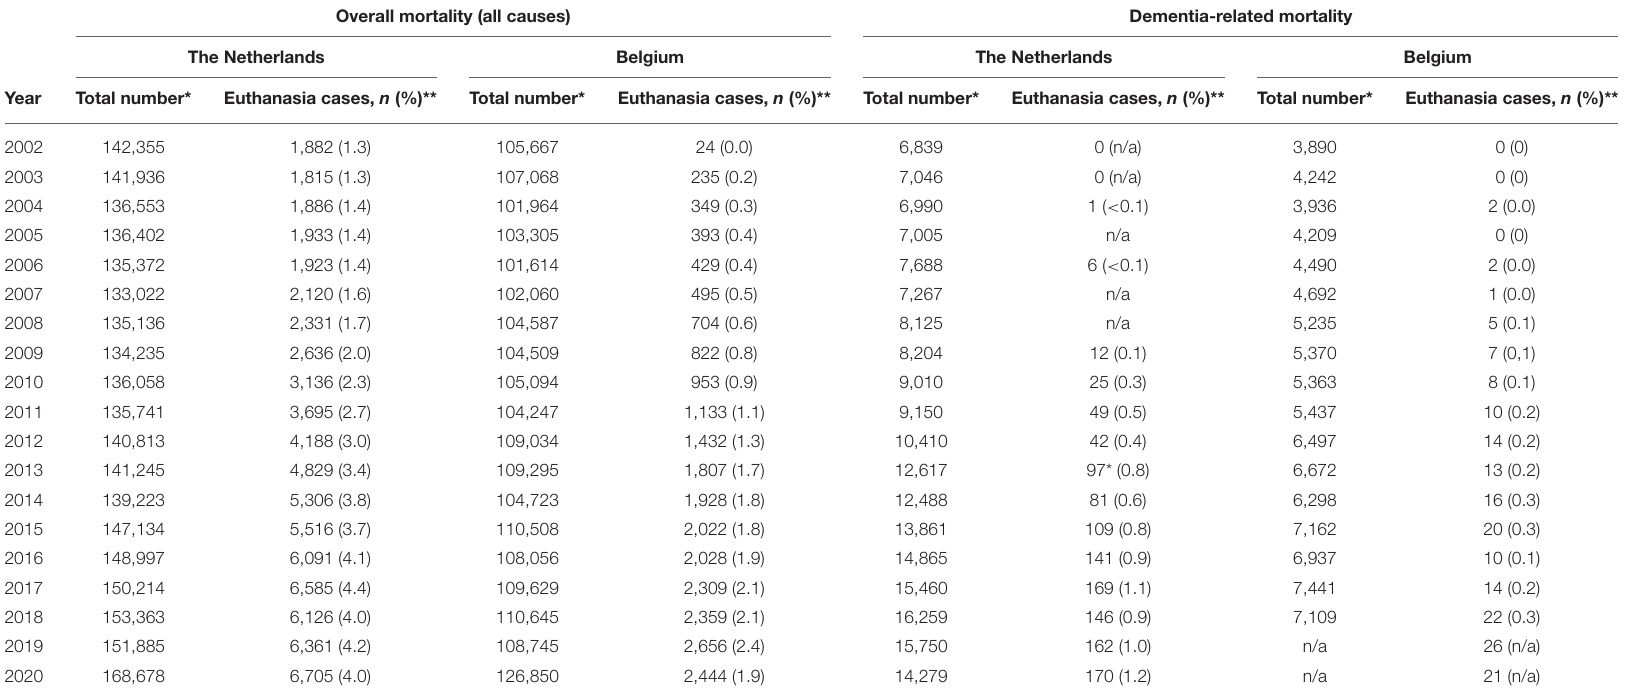
TABLE 2 | Epidemiology of euthanasia based on dementia in the Netherlands and Belgium. Overall mortality (all causes) Dementia-related mortality The Netherlands Belgium The Netherlands